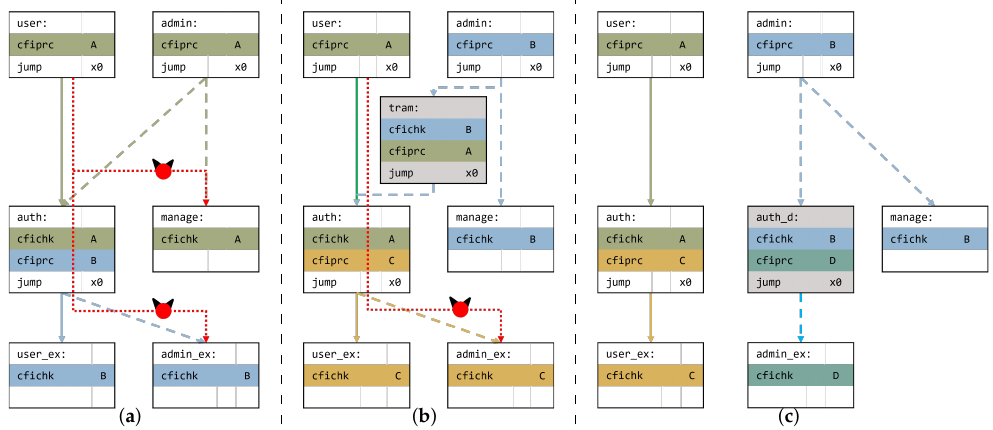
Figure 2. Control-flow sensitive example. Each line style represents a different path level. The solid shows user-level and the dashed shows admin-level. The red dotted line means unintended malicious paths: ( a ) problem state; ( b ) trampoline; and ( c ) duplication.